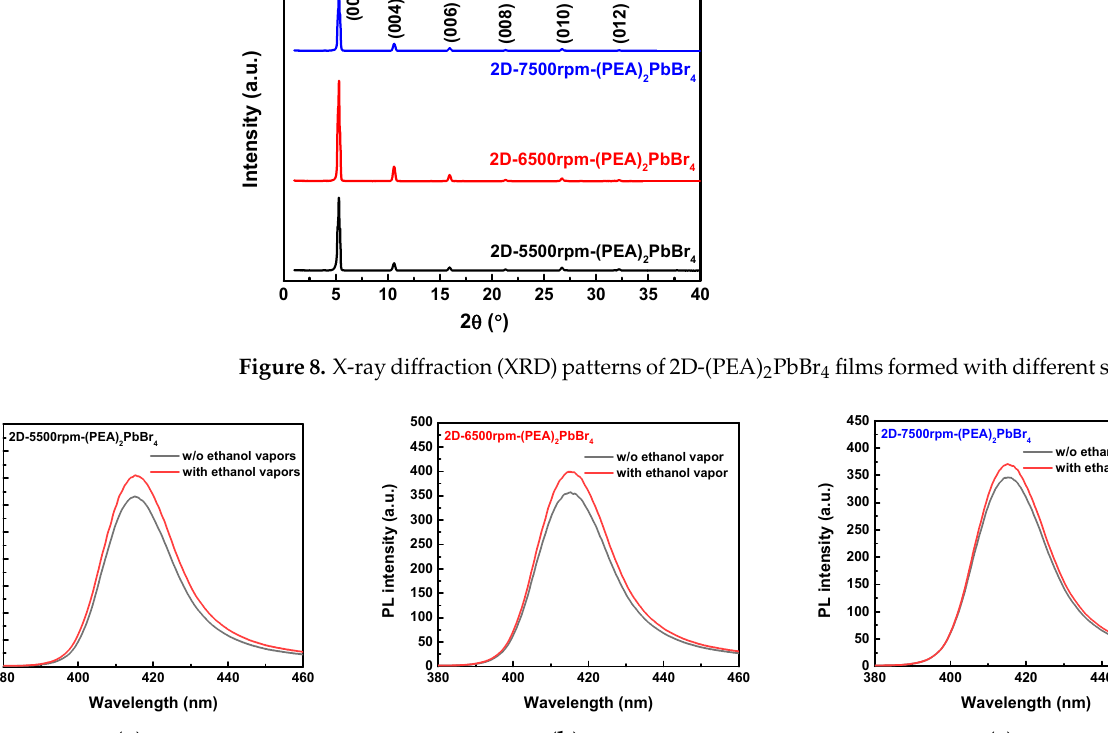
Figure 9. Photoluminescence (PL) intensities of 2D-(PEA) 2 PbBr 4 films formed with different spin speeds in ethanol vapors environment. ( a ) 2D-5500rpm-(PEA) 2 PbBr 4 film. ( b ) 2D-6500rpm-(PEA) 2 PbBr 4 film. ( c ) 2D-7500rpm-(PEA) 2 PbBr 4 film. The current response ratio for different spin coating speeds of the 2D-(PEA) 2 PbBr 4 films were investigated. From the FESEM results, it was known that the 2D-6500rpm-(PEA) 2 PbBr 4 perovskite film was relatively dense and had fewer grain boundaries. The 2D-5500rpm-(PEA) 2 PbBr 4 perovskite was relatively uniform, but there were many grain boundaries. The I–V curves of the (PEA) 2 PbBr 4 films formed with three different spin